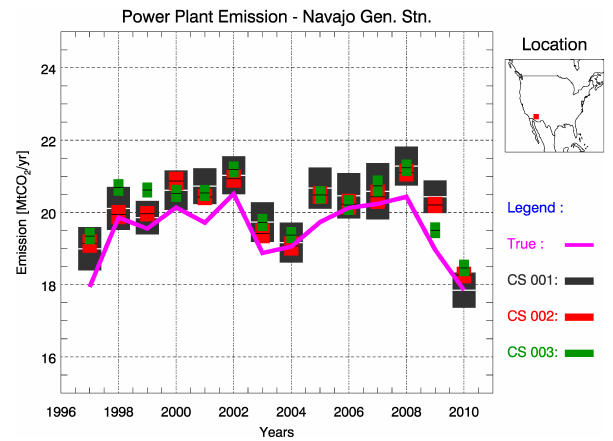
Fig. 12. Same as Fig. 11 for the Navajo generating station in Ari- zona,